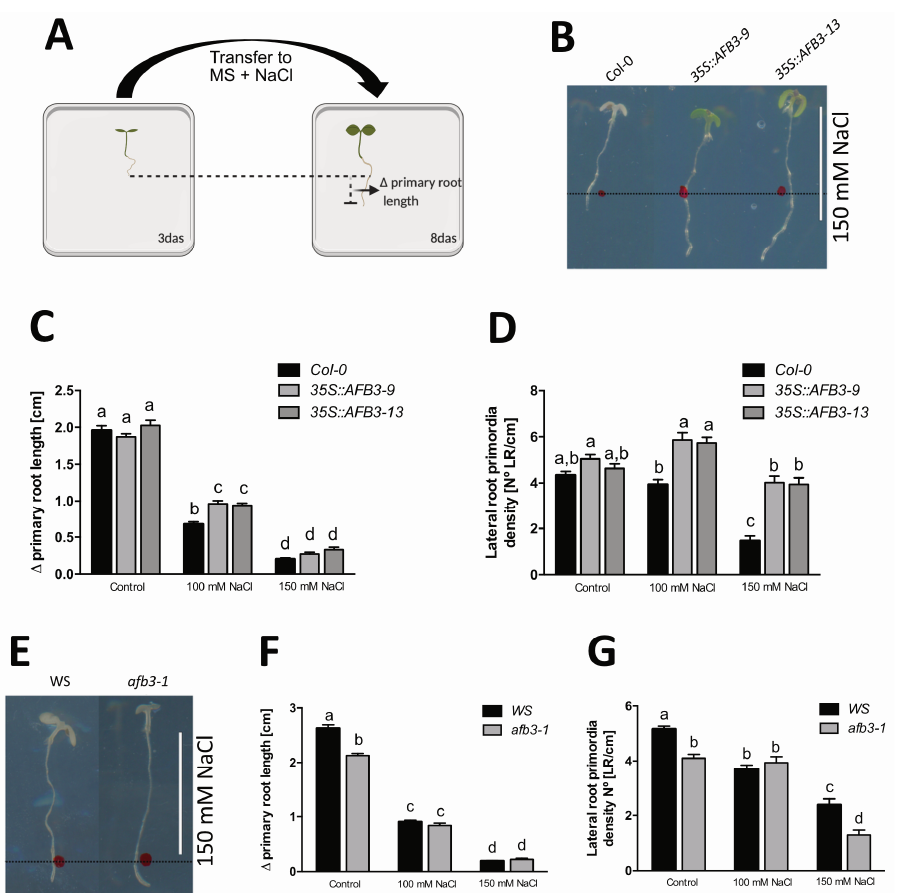
Figure 2. AFB3 over-expression enhances salt stress tolerance in Arabidopsis thaliana roots. Three-day-old Col-0 WT, p35S::AFB3 , WS, and afb3-1 were transferred onto MS medium supplemented with 0, 100, or 150 mM of NaCl and cultivated for additional five days. ( A ) Schematic representation of primary root growth quantification under salt stress ( ∆ primary root length). ( B ) Representative Col-0 WT and p35S::AFB3 in 150 mM NaCl are shown. ( C , D ) Primary root growth ( C ) and lateral root primordia density ( D ) of Col-0 WT and p35S::AFB3 lines after transfer to NaCl-containing media were quantified. ( E ) Representative Wassilewskija (WS) and afb3-1 seedlings in 150 mM NaCl are shown. ( F , G ) Primary root growth ( F ) and lateral root primordia density ( G ) of WS and afb3-1 seedlings after transfer to NaCl-containing media were quantified. Two-way ANOVA and Bonferroni a posteriori tests were performed. a, b, c, d represents statistically significant di ff erences with p < 0.05. Error bars represent the standard error of the mean. Each experiment was performed at least three independent times, with 12 seedlings each replicate. Scale: 1